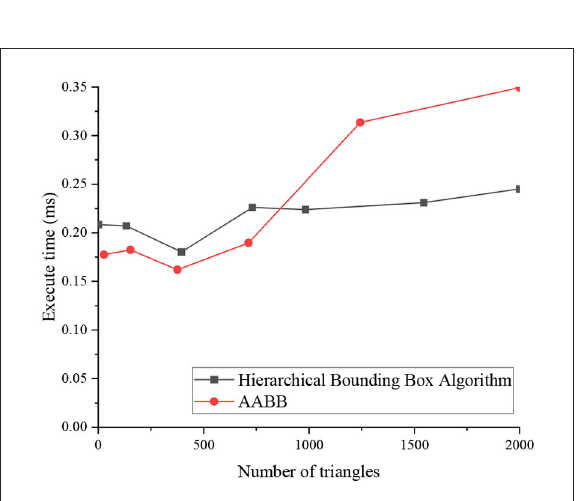
FIGURE9 Time required for collision detection by two algorithms with different numbers of triangles. FIGURE10